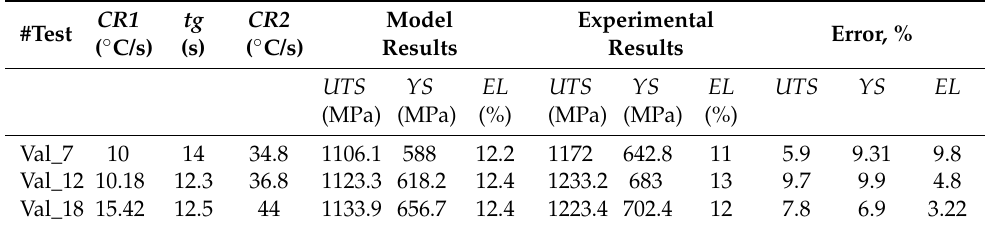
Table 4. Results of genetic optimization compared to experimental